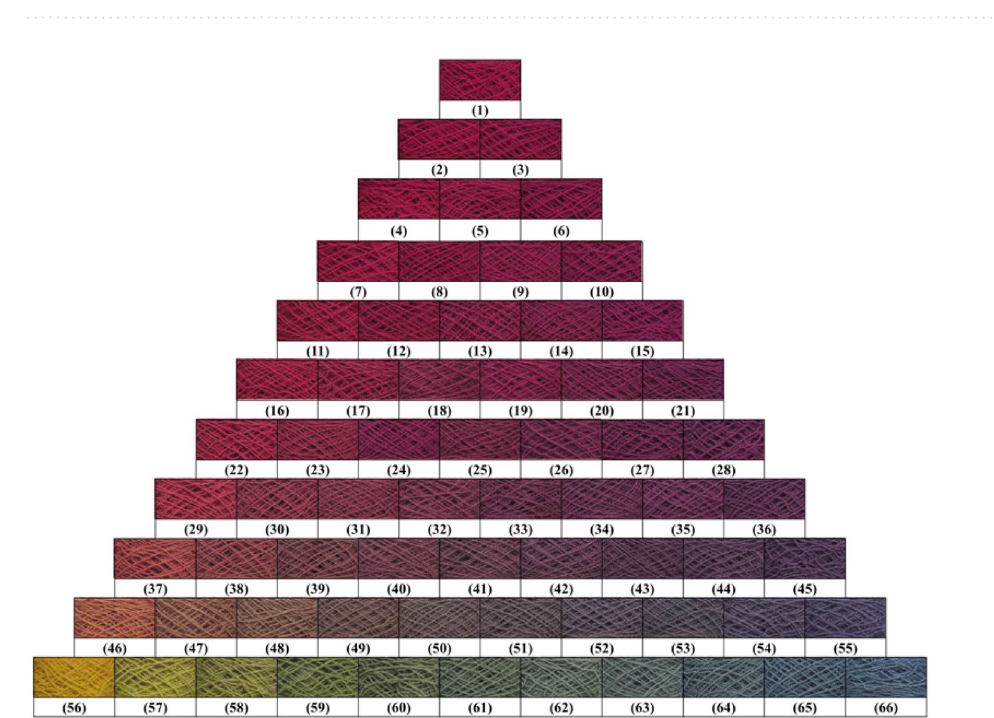
Figure 10. Dyed wool yarn with ternary mixtures of MR, GY, and GB before